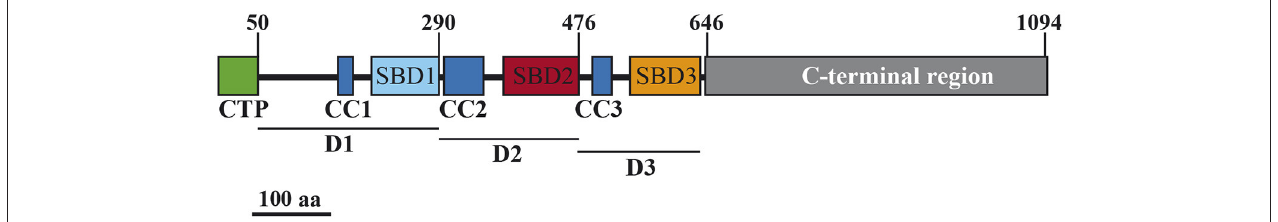
FIGURE 1 | Schematic representation of the AtSS3 protein. Numbers at the top indicate amino acid positions. SBD, starch-binding domain; CC, coiled-coils sites; CTP, chloroplast transit peptide. D1, D2, and D3 are the domains employed in this study.